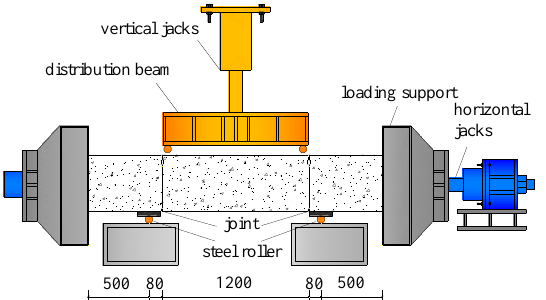
Figure A4. View of specimens and loading device for shear resistance experiment.